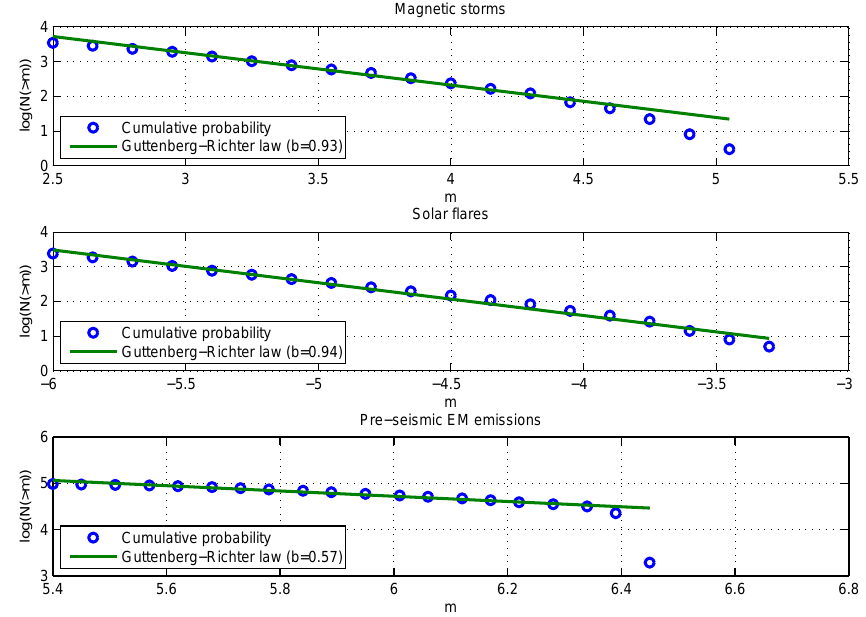
Fig. 2. We use the Gutenberg-Richter law (Eq. 5) to calculate the cumulative number of D st data, N(> m) (upper panel). There is an agreement of the aforementioned formula for b = 0 . 93 with the D st time series. We then use the Gutenberg-Richter law to calculate the cumulative number of X-ray flux data, N(> m) (middle panel). There is an agreement of the aforementioned formula for b = 0 . 94 with the X-ray flux time series. Finally, the Gutenberg-Richter law is used to calculate the cumulative number of pre-seismic EM emission data, N(>m) (lower panel). There is an agreement of the aforementioned formula for b = 0 . 57 with the pre-seismic EM emission time